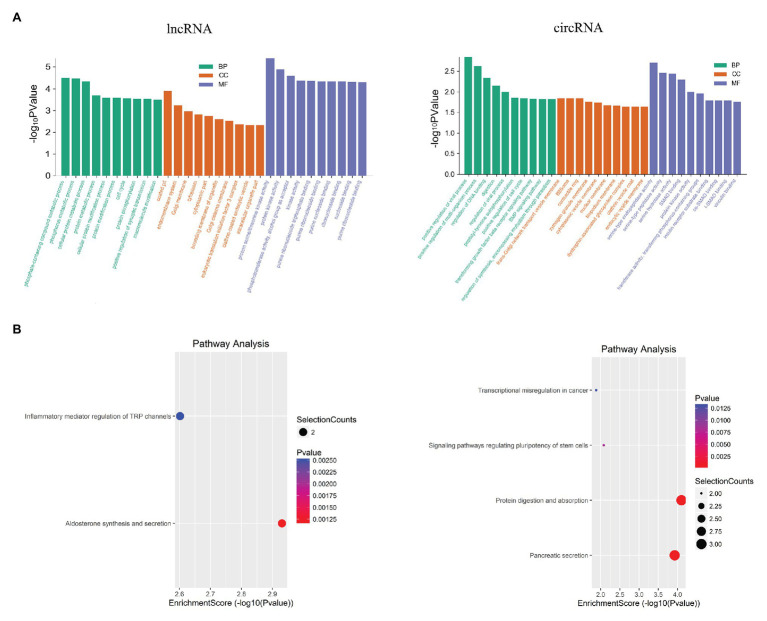
Functional analysis for the differentially expressed mRNAs, lncRNAs and circRNAs. (A) GO enrichment analysis for up-regulated mRNAs, up-regulated lncRNAs and the down-regulated circRNAs. Red bars are biological process, green bars are cell component, and blue bars are molecular function. The ordinate is -Log10 p value (-LgP). The larger the -LgP value, the smaller the P value, indicating that the enrichment of differentially expressed mRNA/lncRNA/circRNA in a given pathway is more significant. (B) KEGG pathway enrichment analysis for up-regulated mRNAs, up-regulated lncRNAs, and for down-regulated circRNAs. Size represents the number of enriched genes, and color indicates the degree of enrichment. Higher enrichment scores correlate with lower p-value, indicating that the enrichment of differentially expressed genes in the given pathway is significant.